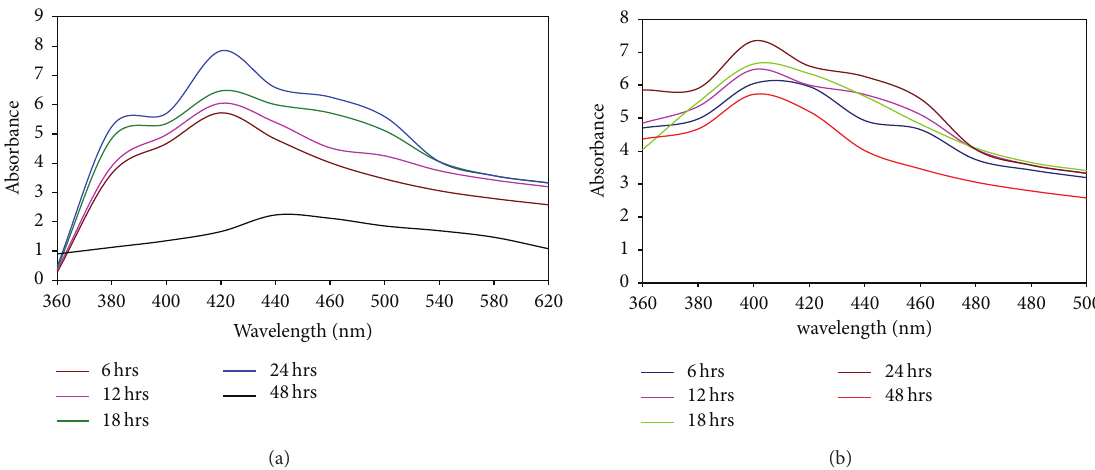
Figure 2: Absorption spectrum of nanoparticles synthesized by the culture supernatant of K. pneumoniae and SPR band at 420nm for CdS (a) and 400 nm for ZnS (b).